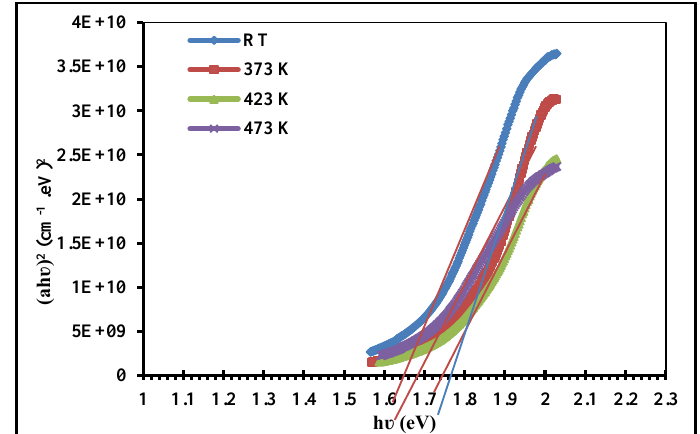
Fig.5: (αhʋ) 2 versus photon energy of incident radiation for as-deposited and annealed Blend NiPcTs/Alq thin films (Q-band). 3